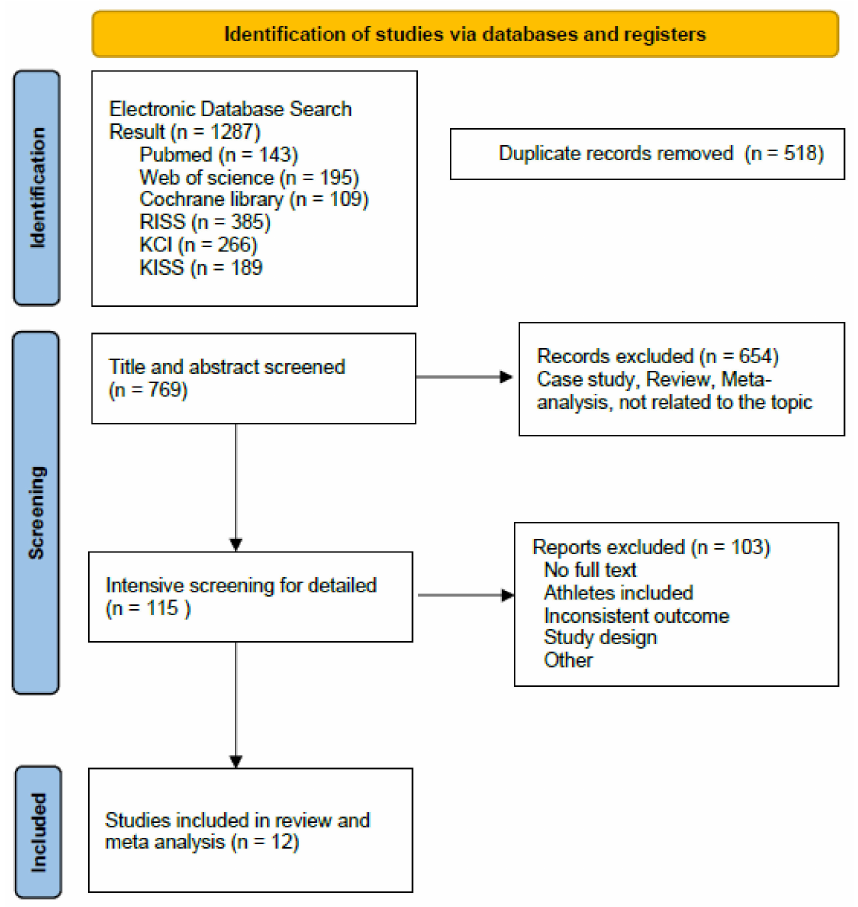
Figure 1. Flowchart of the study selection